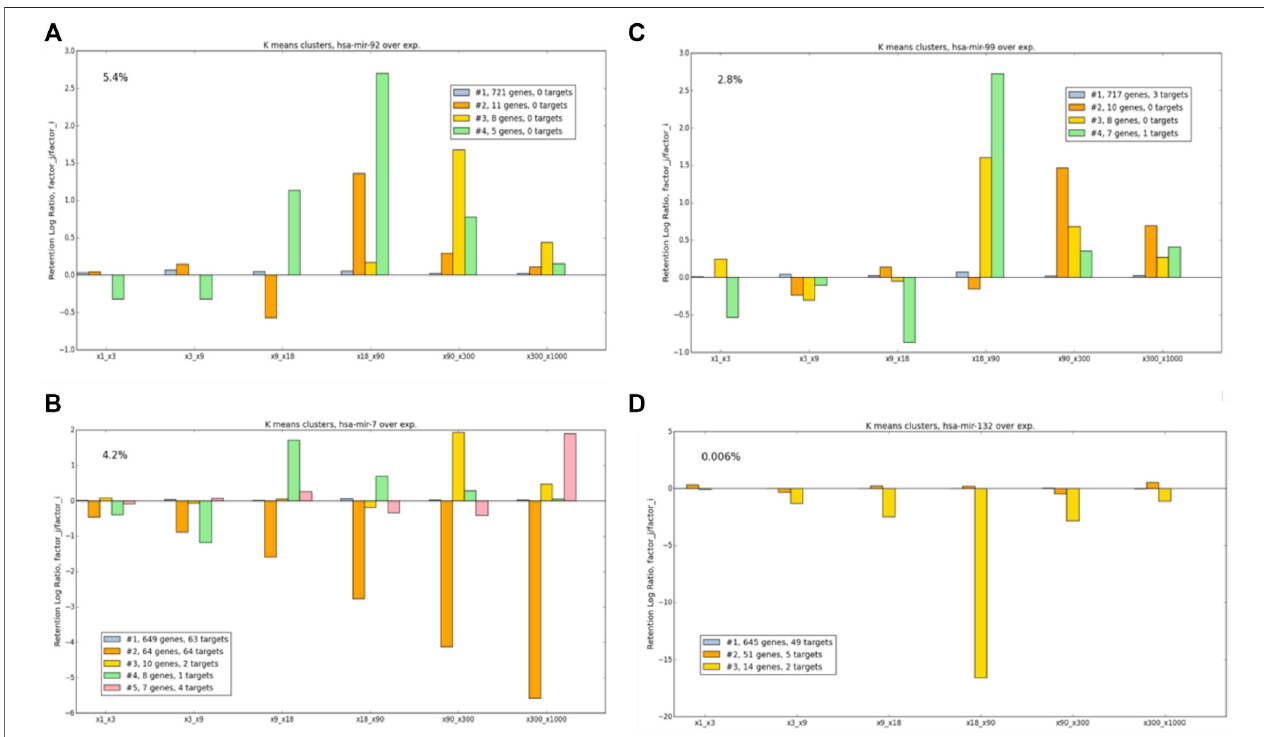
FIGURE 7 | Example of OXR classes for different miRNAs, following manipulations of (A) has-mir-92, (B) hsa-mir-7, (C) hsa-mir-99, and (D) hsa-mir-132. The numbersofthetargetsofeachtestedmiRNAareindicated(seecolorlegend).miRNAexpression(%ofallmiRNAinthecell)ismarked.Thevaluesaty-axisareexpressed by